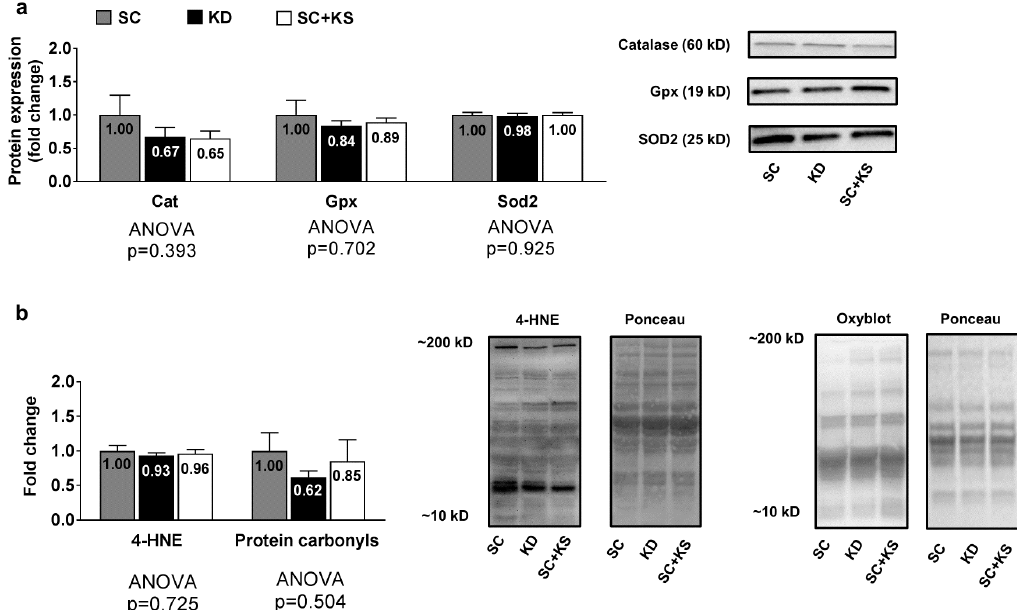
Figure 5. Gastrocnemius oxidative stress-related proteins and markers in 8 month-fed rats. Legend: Gastrocnemius catalase (Cat), glutathione peroxidase (Gpx), and mitochondrial superoxide dismutase (Sod2) protein levels are presented with representative images in panel ( a ). In panel ( b ), tissue 4-hydroxynonenal (4-HNE) and protein carbonyls (Oxyblot) are presented with representative images. Fold-change for each protein are expressed relative to the SC group, all bars are presented as mean ± standard error values ( n = 7–8 per group), group means are indicated within each bar and ANOVA p -values are presented below data. Abbreviations: SC, standard chow-fed rats; KD, ketogenic diet-fed rats; SC + KS, standard chow-fed rats with supplemental sodium beta-hydroxybutyrate. 3.6. Effects of Long-Term Feedings on Brain Oxidative Stress-Related Proteins and Markers Brain protein expression levels of Cat (ANOVA p = 0.331), Gpx (ANOVA p = 0.084) and Sod2 (ANOVA p = 0.741) were not differentially expressed between groups (Figure 6a). Likewise, brain 4- HNE (ANOVA p = 0.676) and protein carbonyl levels (ANOVA p = 0.905) were not differentially expressed between groups (Figure 6b).